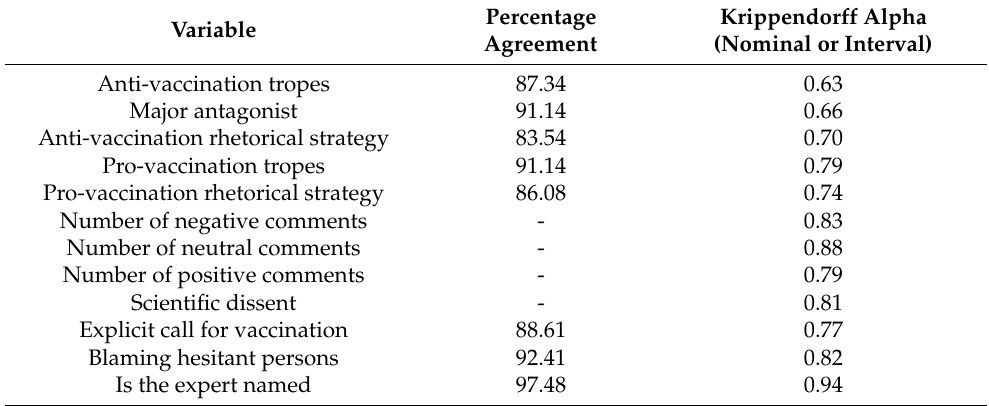
Table 1. Reliability measures.